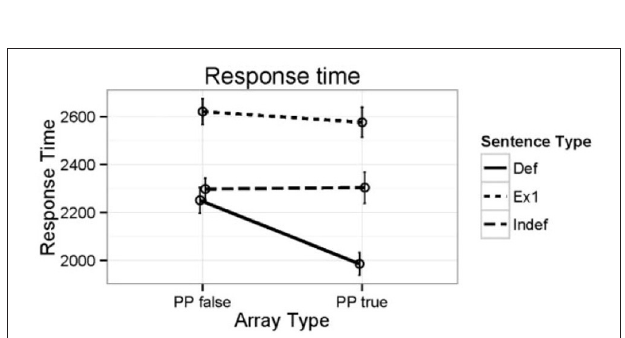
FIGURE 13 | Experiment 1 by Schwarz